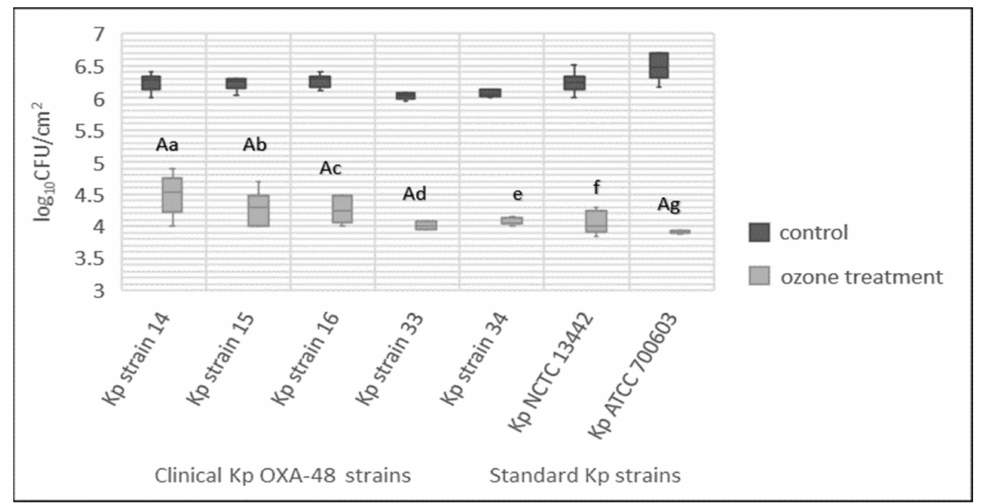
Figure 3. Total bacteria count expressed as log10 CFU/cm 2 of 7 tested strains of Klebsiella pneumoniae (Kp). Results shown with median value (-) and minimum and maximum value. The lowercase letters, a–g, express the statistically significant difference between the treated and control group for the 7 tested strains (Mann–Whitney U test, p < 0.05). The capital letter A marks the statistically significant difference between Kp ATCC 700603 and OXA-48-producing strains Kp strain 14, Kp strain 15, Kp strain 16 and Kp strain 33, and vice versa (Kruskal–Wallis test, p < 0.05).